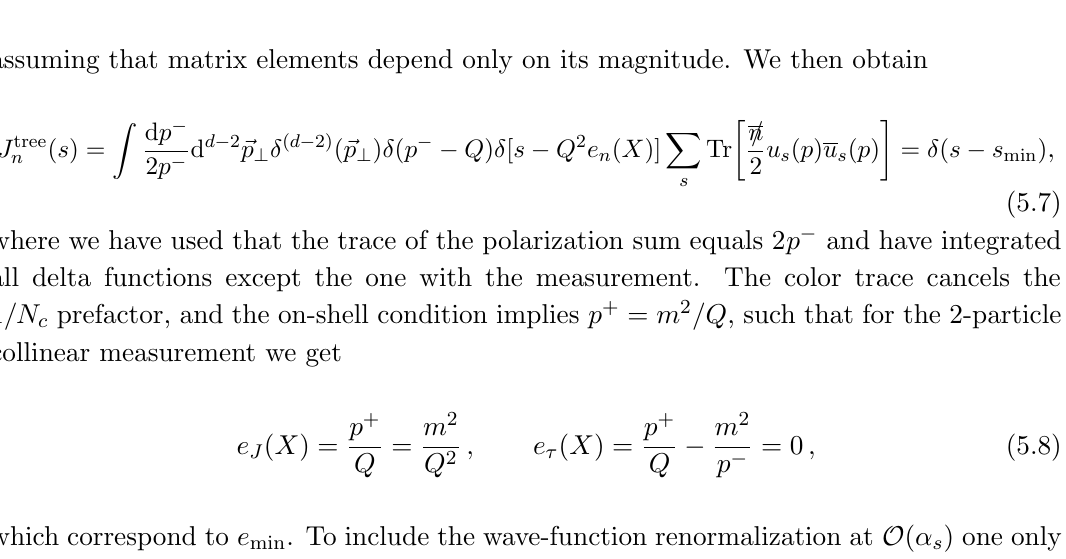
Figure 3 . Virtual diagrams contributing to the jet function at O ( (cid:11) s